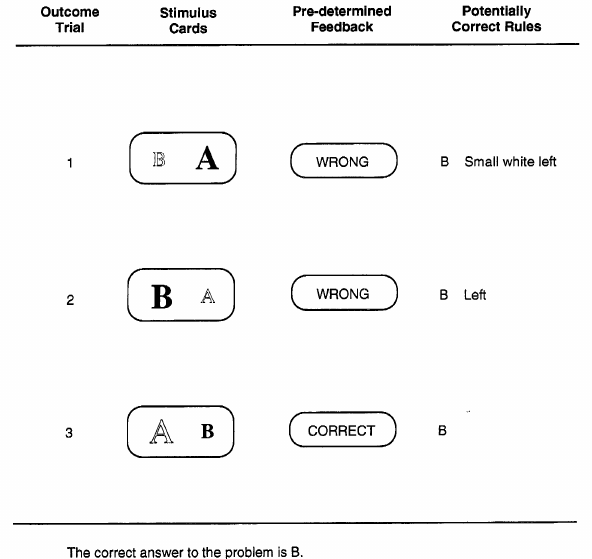
FIG. 1. An example of a four-dimensional problem; the three outcome trials were presented simultaneously in the parallel condition and serially in the serial